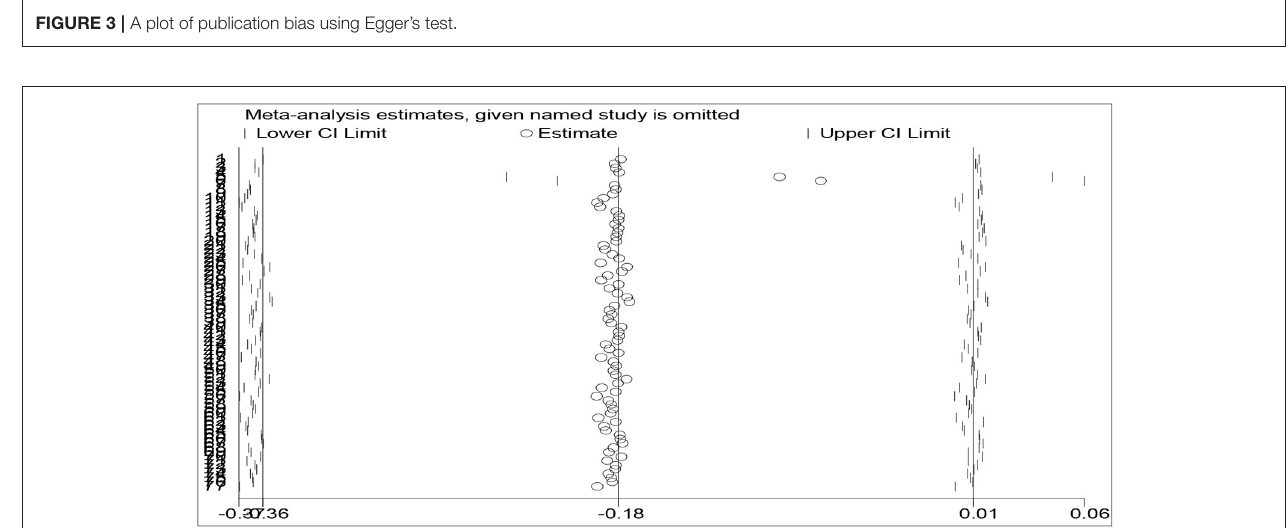
FIGURE 4 | A plot of sensitivity